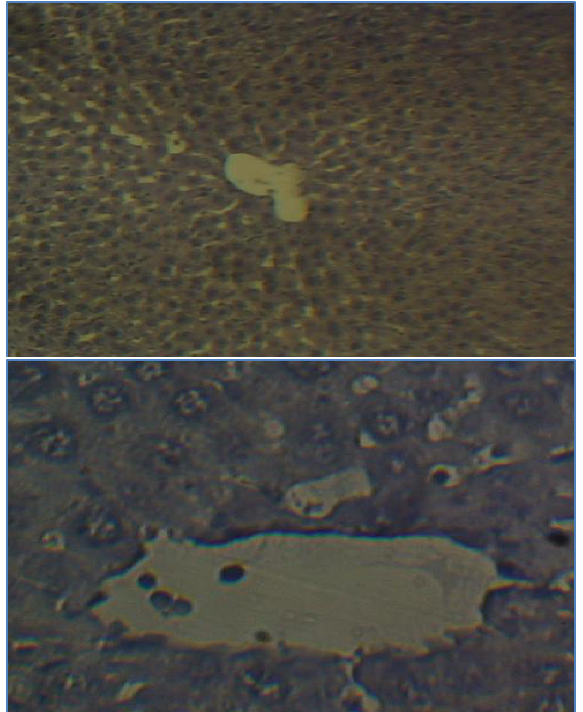
Figure, 2: Left: Liver of amygdalin group, Right liver of magnetic water group. (Normal)